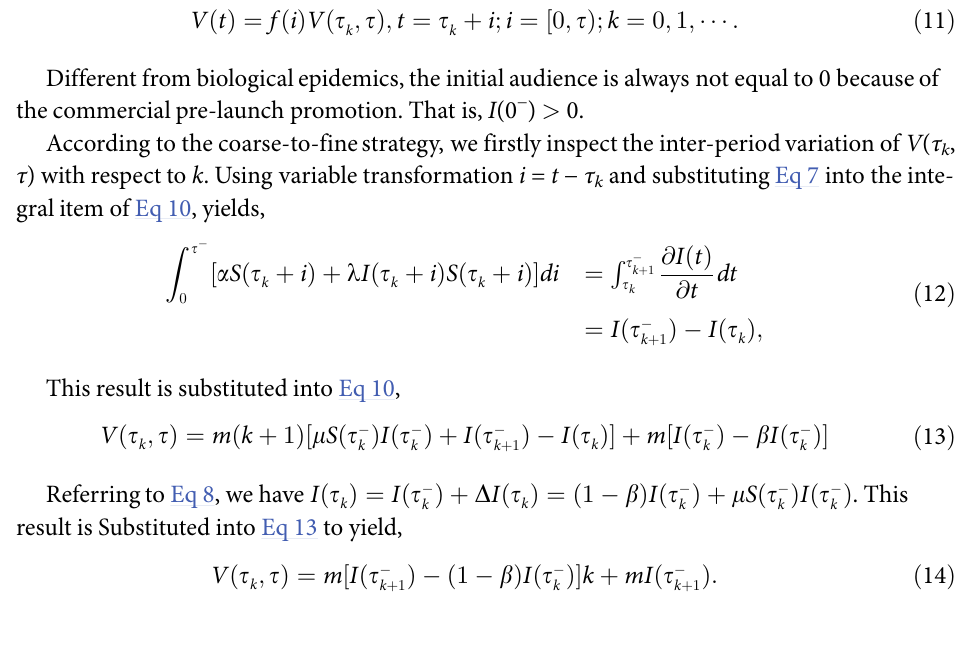
Fig 2. One single-period diffusion process through τ k to τ k +1 . At update time τ k , the impulsive intensity of m S ð t (cid:0) Þ I ð t (cid:0) Þ indicates the newly recruited audience,while removed population b I ð t (cid:0) k k watching, which is only counted at every update time. During non-update periods, external influence α S ( t ) and interpersonal spreading λ S ( t ) I ( t ) occur in every time unit. A concave feverish function is used to fit the imbalanceof the on-demand streaming distribution.